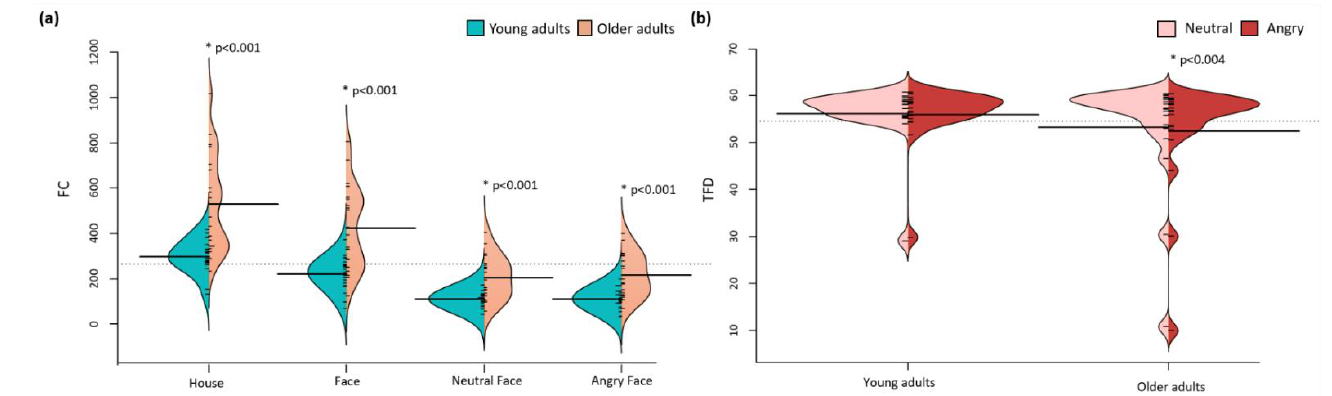
Figure 5. Split violin plots representing the eye-tracking data. ( a ) Fixation count for house, face, neutral face, and angry face conditions. Fixation count was significantly higher in the older adults group for all conditions (all ps < 0.001). ( b ) Total fixation duration for emotion. The results show a significantly higher total fixation duration for neutral versus angry faces ( p = 0.004) within the older adults group. * p < 0.05.